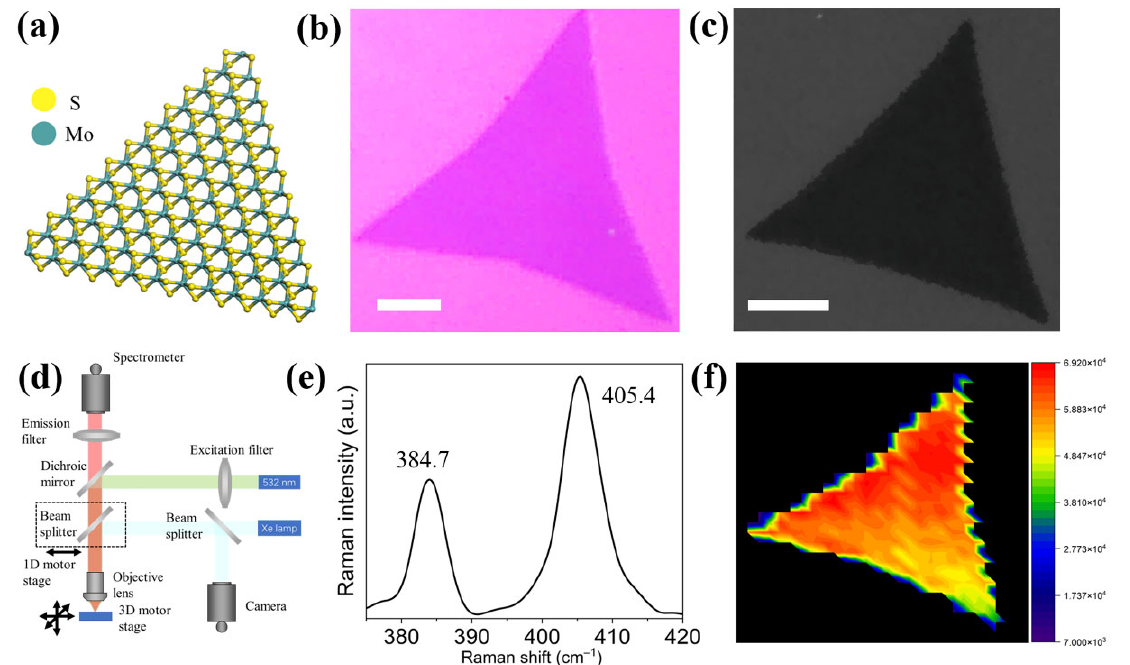
Figure 1. ( a ) Schematic illustration of the atomic structure of a monolayer MoS 2 . ( b ) Optical photograph of a monolayer MoS 2 . ( c ) SEM image of a monolayer MoS 2 . Scalar bar is 10 µ m. ( d ) Structure of the homemade laser scanning confocal microscope. ( e ) Raman spectrum of the monolayer MoS 2 . ( f ) Raman mapping of the monolayer MoS 2 .